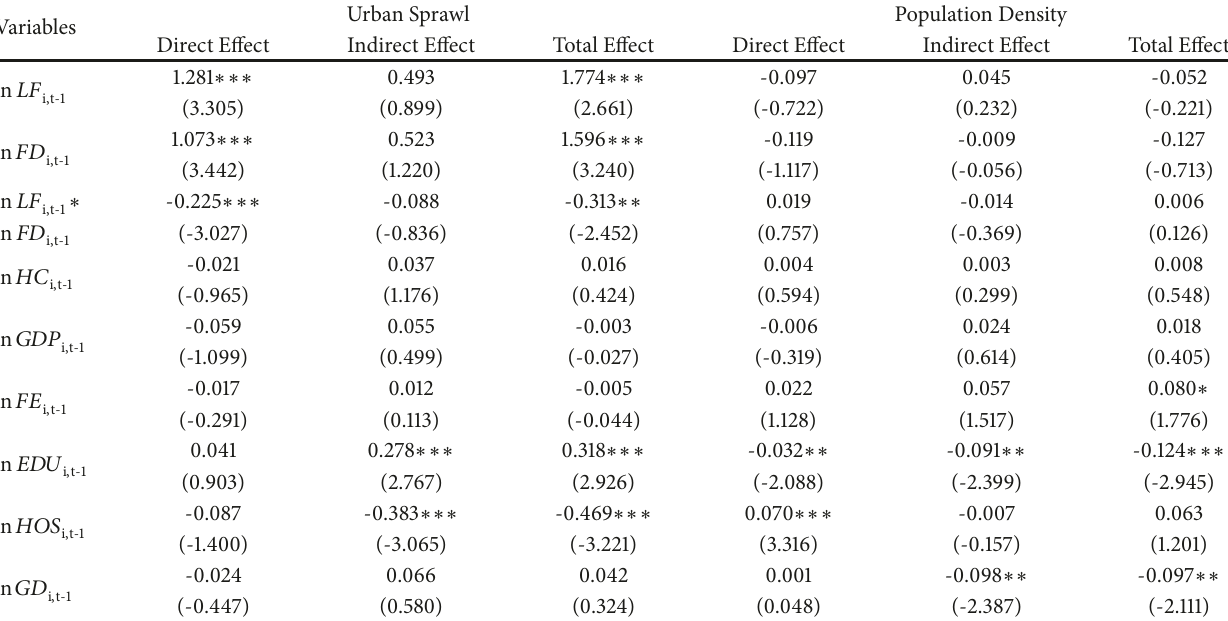
Table 7: The direct, indirect, and total effects of the central